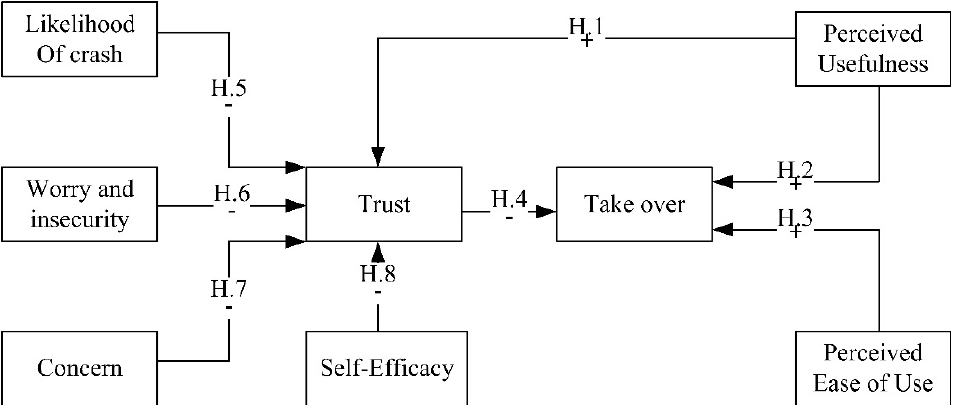
Figure 1. Diagram of the hypothesized model (Hypothesis 1–8). Notes: +: positive impact − : negative impact.